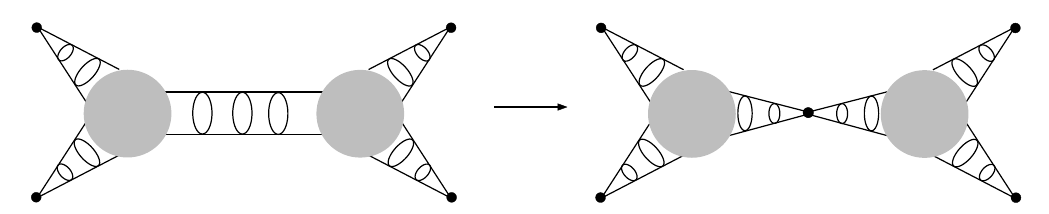
Figure 11. An important step in computing the bilinear four-point function is to use the split representation for the intermediate four-point function, as was shown previously in (cid:12)gure